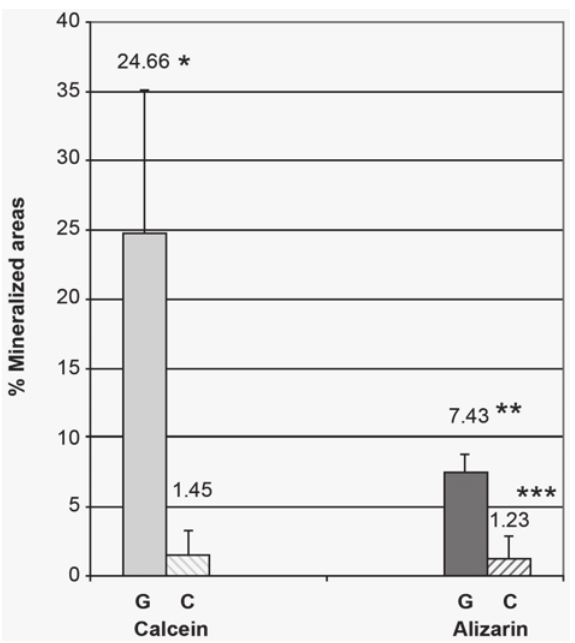
Figure 12- Sum of the areas labeled by calcein and alizarin in the Graft (G) and Control (C) groups. Results are expressed as mean ± standard deviation * Differs significantly from the Control Group. (P < 0.001) (T